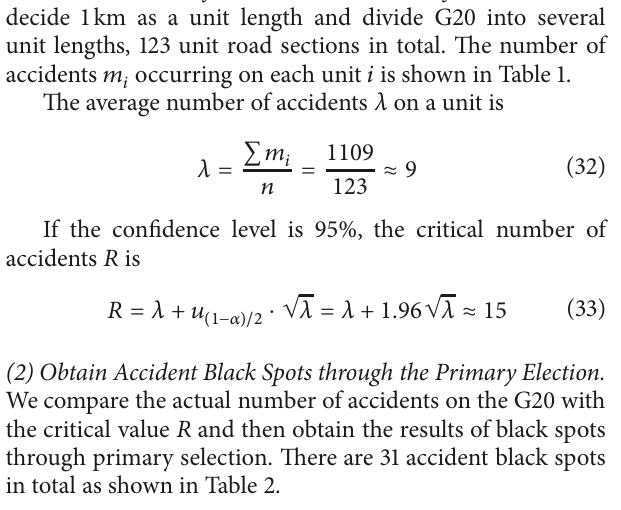
Weifang contains four freeways, which are G18, G25, G20, and S16. Rizhao includes four freeways, which are G15, G1511, G25, and S7801. Linyi has four freeways, which are G2, G20, G22, and